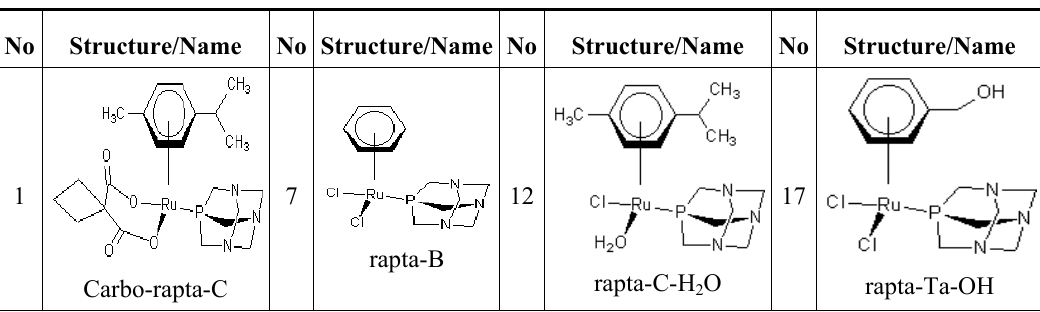
Table 1. The structures of the metal-based